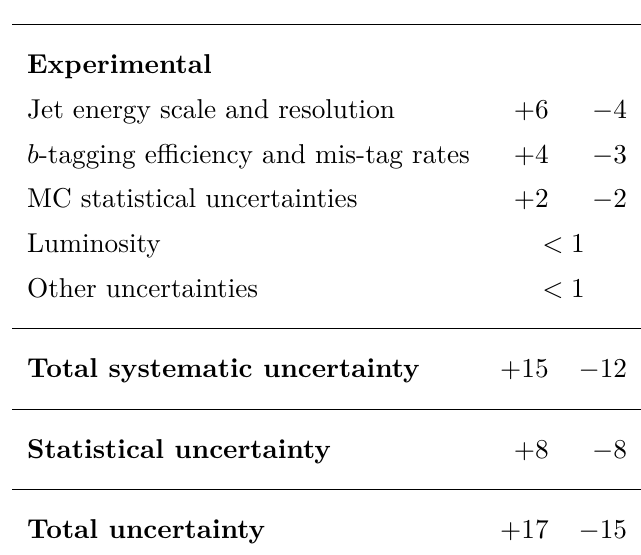
Table 3 . The contribution from different systematic uncertainties to the measured t ¯ tt ¯ t production cross section, σ , grouped into categories. For each uncertainty source, the fit is repeated with the t ¯ tt ¯ t corresponding group of nuisance parameters fixed to their best-fit values, ˆ θθθ . The contribution from each source, ∆ σ , is then evaluated by subtracting in quadrature the uncertainty in σ t ¯ tt ¯ t in this fit from that of the full fit. The contributions from individual groups are compared with the total systematic uncertainty and the statistical uncertainty. The total systematic uncertainty is different from the sum in quadrature of the different groups due to correlations among nuisance parameters in the